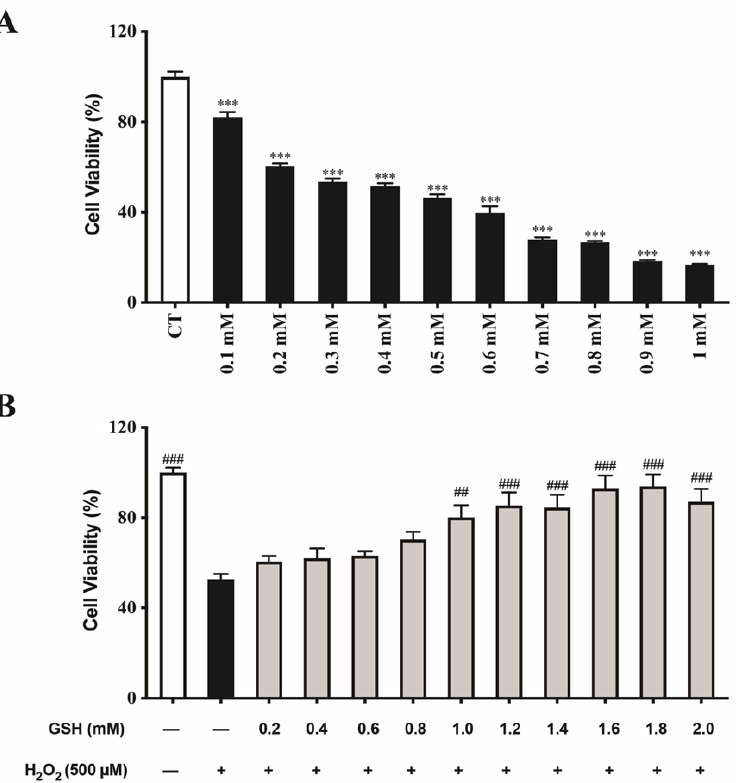
Figure 1. Protective effect of GSH on H 2 O 2 -induced cytotoxicity in IPEC-J2 cells. ( A ) Cells were seeded in 96-well plates (5 × 10 3 cells per well) and treated with H 2 O 2 (500 µ M) for 24 h. The cell viabil- ity was determined by the CCK-8 assay. Values are presented as the mean ± SEM ( n = 6). *** p < 0.001 vs. control (CT) group. ( B ) Cells were pretreated with H 2 O 2 (500 µ M) for 24 h. Subsequently, without or with GSH at the indicated concentration and the plate was incubated for another 24